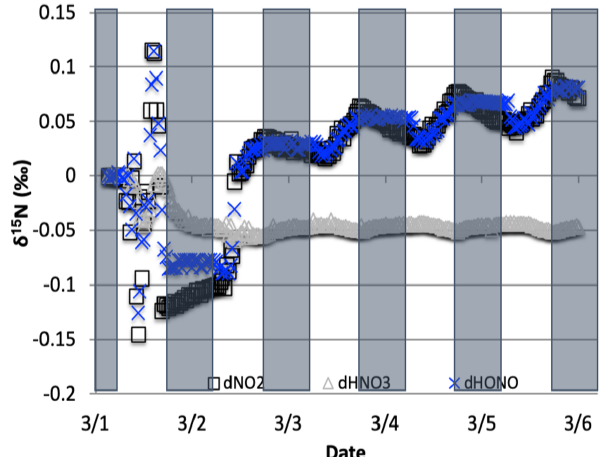
Figure 11. The difference between the δ 15 N values of NO 2 , HONO, and HNO 3 when NO 3 + VOC → HNO 3 reactions are included and excluded (NO was omitted for clarity). The 5d simulation was un- der the conditions list in Table S3e. Total VOC mixing ratios during the last day of the 1 March simulation was 550–670ppbC.